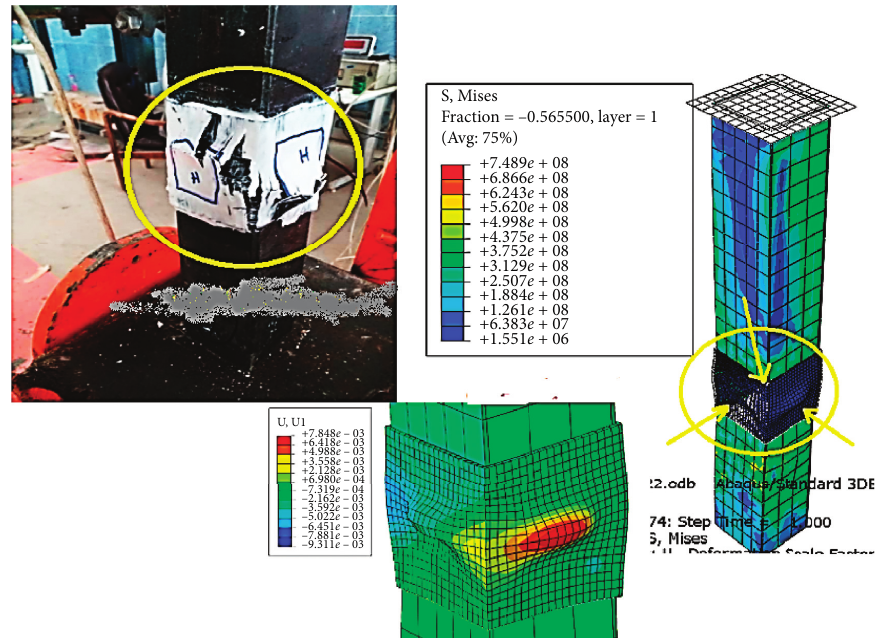
Figure 15: Comparison of the reinforcement of a defective sample in two adjacent walls of a short steel